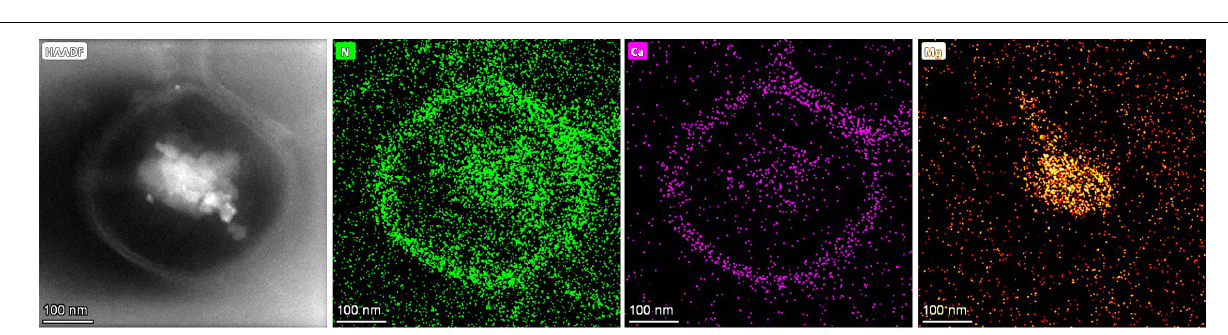
FIGURE 13 | The typical elemental distribution of N, Ca, and Mg on an ultra-thin section of Vibrio harveyi QPL2 cell cultured under the condition of a Mg/Ca ratio of